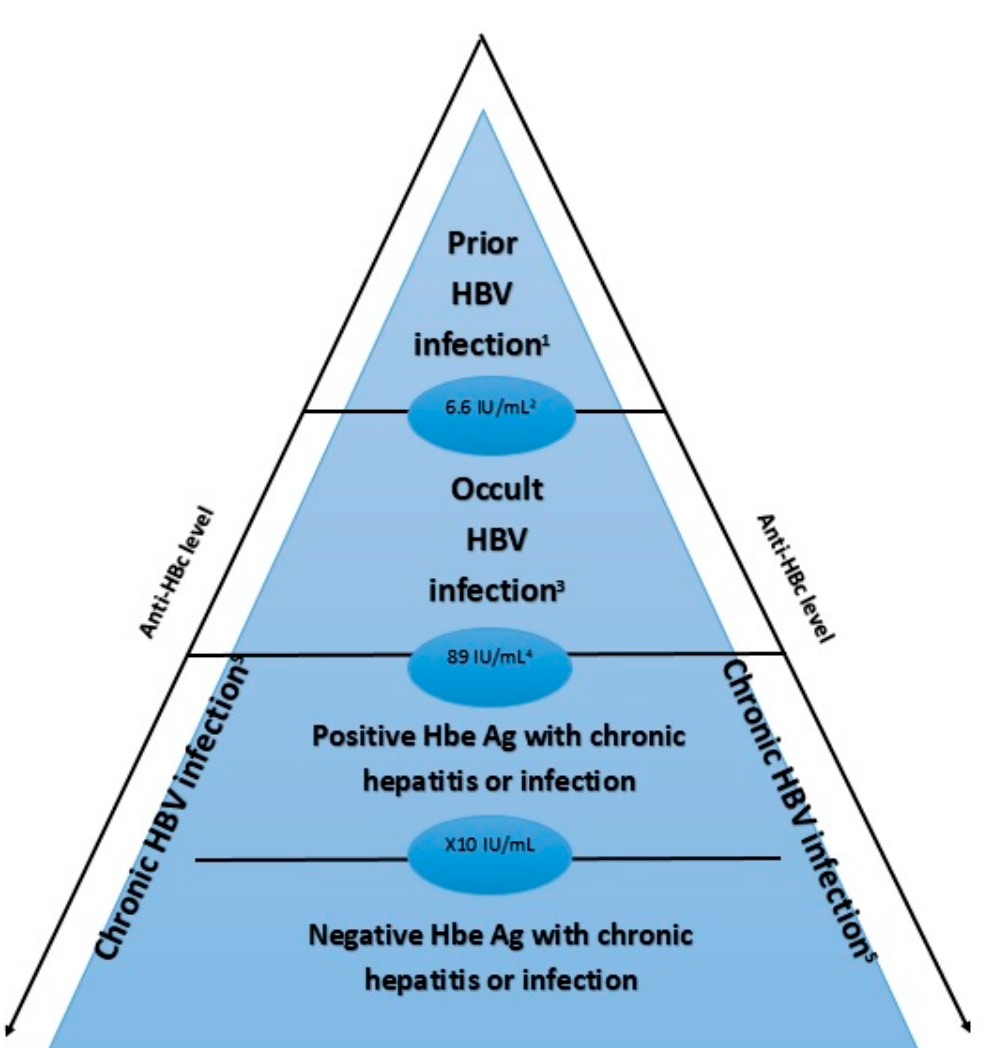
Figure 2. Level of anti-HBc depending on the stage of HBV infection. This figure represents the level of anti-Hbc according to the phase of HBV infection. It has been shown that anti-HBc level is higher in case of chronic HBV infection (especially in case of negative HbeAg) than in occult HBV infection and prior HBV infection. 1 Prior HBV infection: HBsAg -, anti-HBc +, HBV DNA -, ALT/AST normal 2 Cutoff 6.6 IU/mL: sensitivity of 60.7% and specificity of 75.3% 3 Occult HBV infection: HBsAg -, anti-HBc +, HBV DNA + 4 Cutoff 89 IU/mL: sensitivity of 95.8% and specificity of 98% 5 Chronic HBV infection: HBsAg + for ≥ 6 months HBV: Hepatitis B Virus anti-HBc: Hepatitis B core antibody; HBeAg: hepatitis B e-antigen.